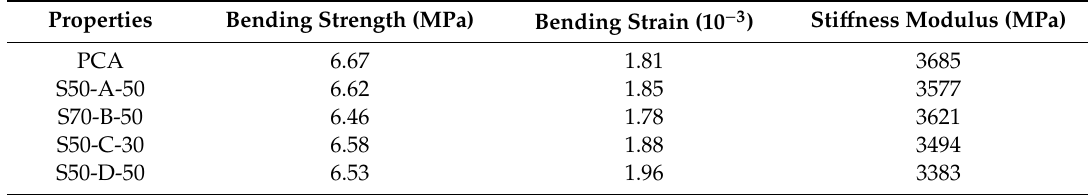
Table 14. Low temperature bending test results.